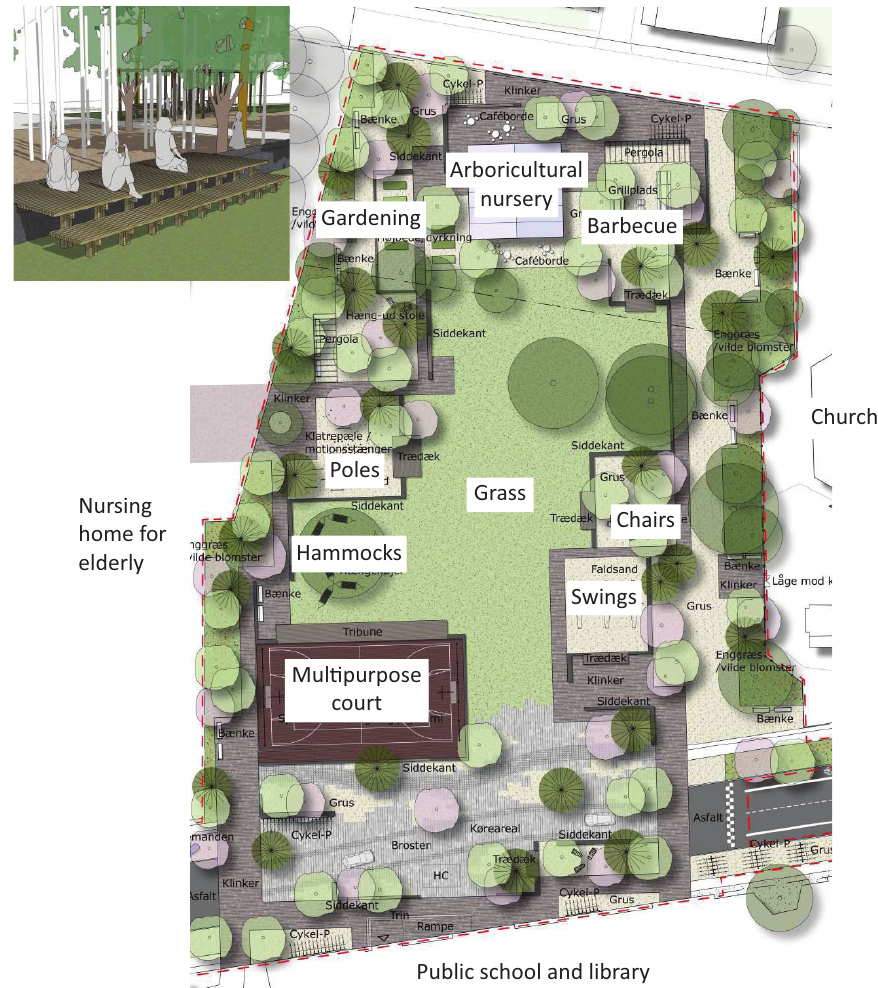
Figure 4. Plan and design of the Garden. Note: The upper left corner illustrates the vision of facilities for seating between activity zones. Source: Authors’ work based on Copenhagen Municipality and 1:1 Landskab